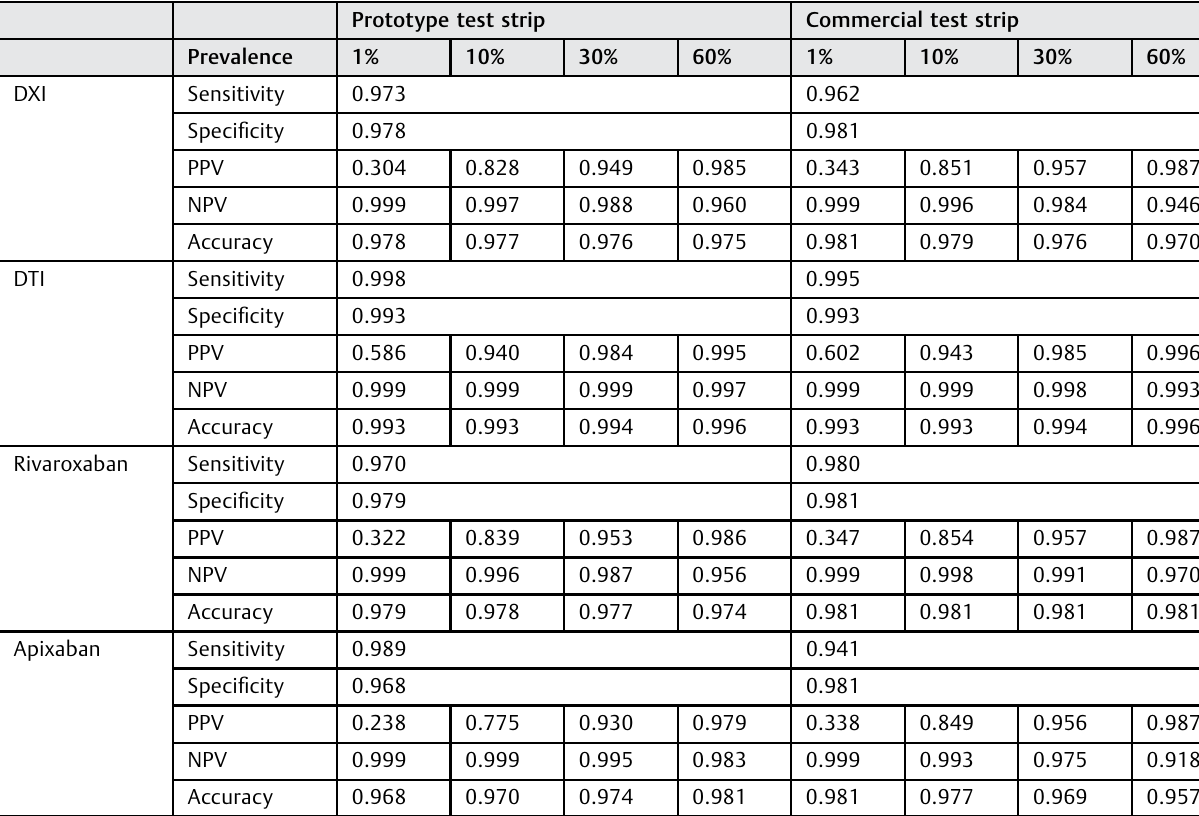
Table 4 Simulated comparison of sensitivity, speci fi city, PPV, NPV and accuracy for the prototype and commercial test strips at a prevalence between 1% and